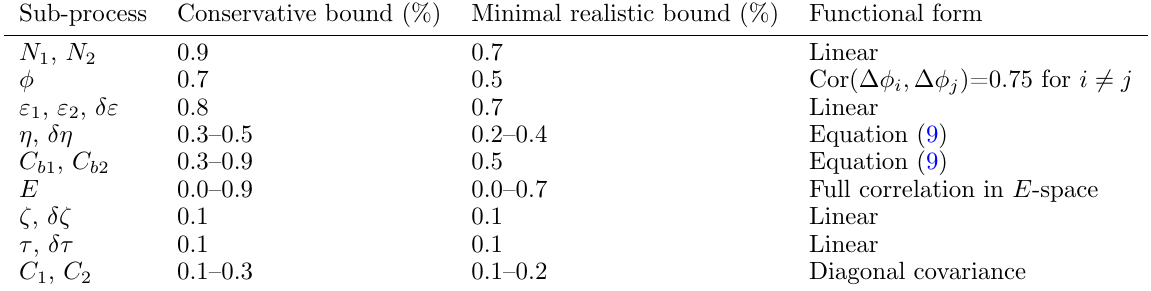
Table 2. The conservative and minimal realistic one-sigma bounds relative to the 239 Pu(n,f) cross-section for each sub-process are summarized. If these uncertainties vary in size with incident neutron energy, their range is provided and shown explicitly in Figure 4. Also, functional forms are briefly summarized. The variables listed are defined in Table 3.